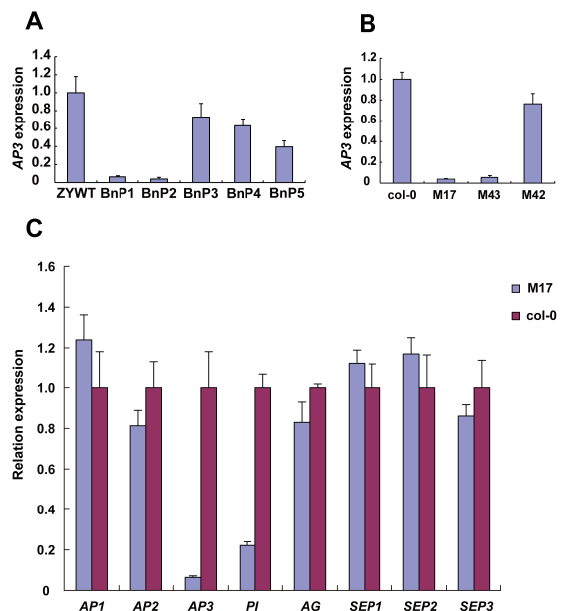
Figure 3. RT-PCR analysis of selected target genes. ( A ) AP3 expression of transgenic rapeseed BnP1 and BnP2 with severe morphological defects and BnP3, BnP4, and BnP5 with slight morphological defects, ZYWT (wild-type); ( B ) AP3 expression of transgenic Arabidopsis M17, M43 with morphological defects, and M42 with no defects, Col-0 (wild plant)(http: // katahdin.mssm.edu / kismeth / revpage.pl) [32–34]; ( C ) the levels of class A, B, and C transcripts. All the rapeseed (P1–P5) and Arabidopsis (M17, M42, M43) transgenic lines contain the PCSR construct. The expression levels were controlled using the signal from the ACTIN gene. The average ( ± SD) values are shown from three biological duplicates of quantitative reverse transcription